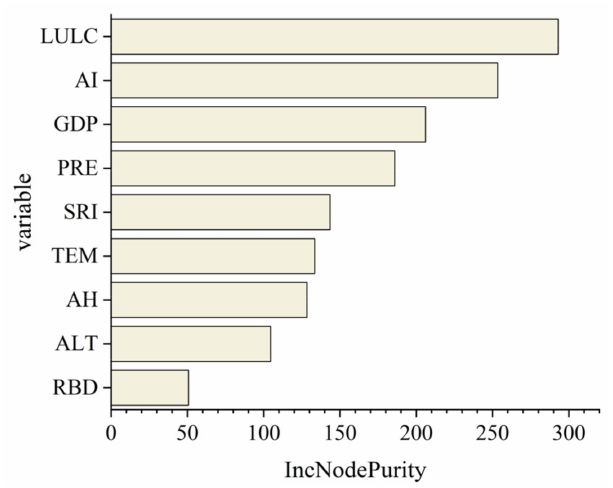
Figure 9. Importance ranking results of the RF